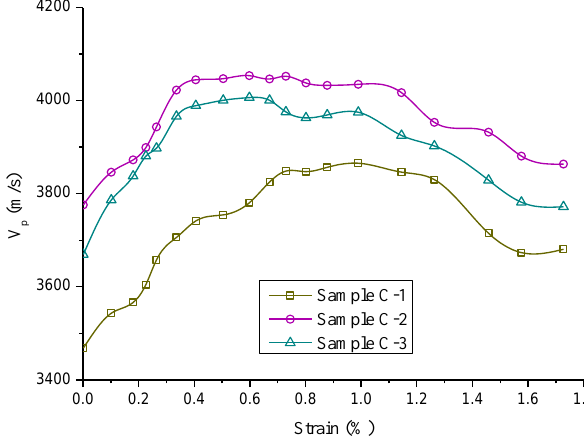
Figure 12. Influence of mining paths on the evolution of P-wave velocity.